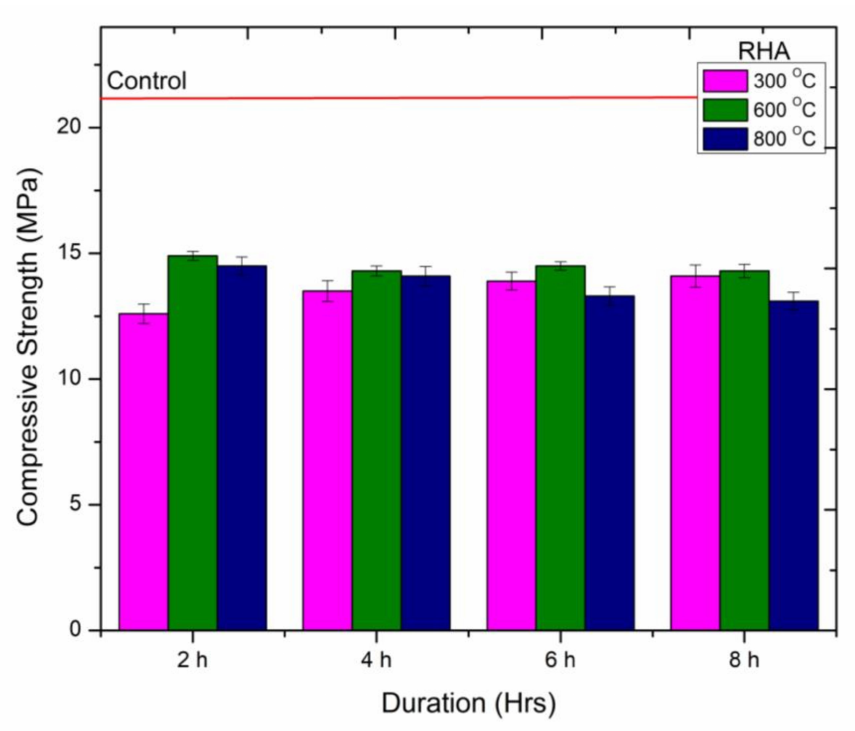
Figure 4. Compressive Strength behavior of RHA-cement mortar at different calcination